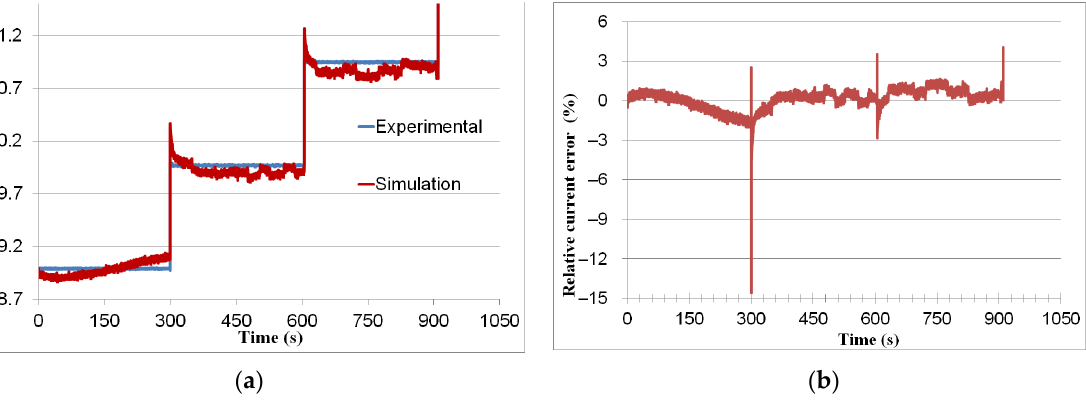
Figure 4. ( a ) Simulation and experimental curves of current. ( b ) Relative error of simulated current.